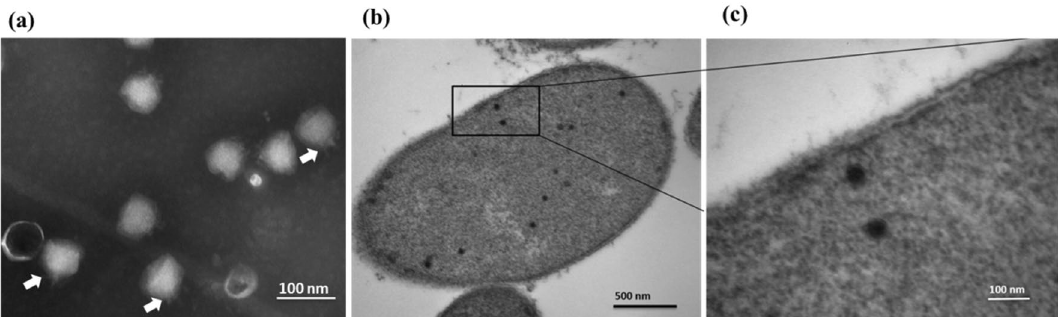
Figure 2. Morphology of phi50-12. ( a ) Electron micrograph of phi50-12 demonstrates that it resembles podoviruses with short tails; arrow heads indicate the tails of phi50-12. ( b ) Electron micrograph of thin section reveals phi50-12 virions inside the cell and ( c ) the loss of cell surface integrity during the release of